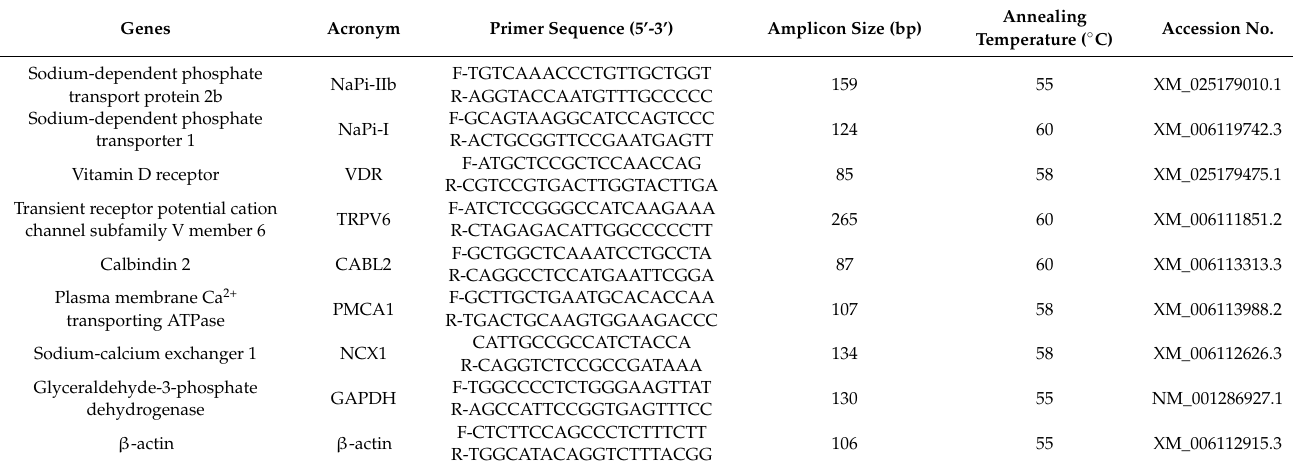
Table 2. Primer sequences for quantitative real-time PCR analysis in Chinese soft-shelled